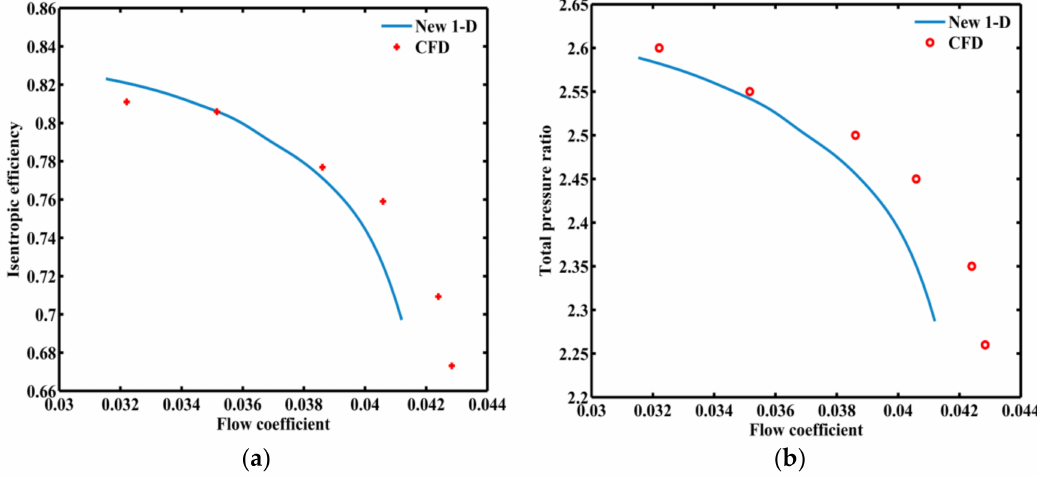
Figure 19. Performance prediction with the new model (1 MWe). ( a ) efficiency; ( b ) pressure